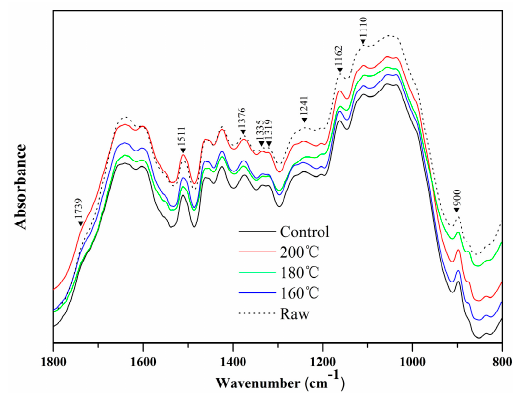
Figure 2. Fourier transform infrared (FT-IR) spectra of wheat straw and fiberboards produced at different temperatures.